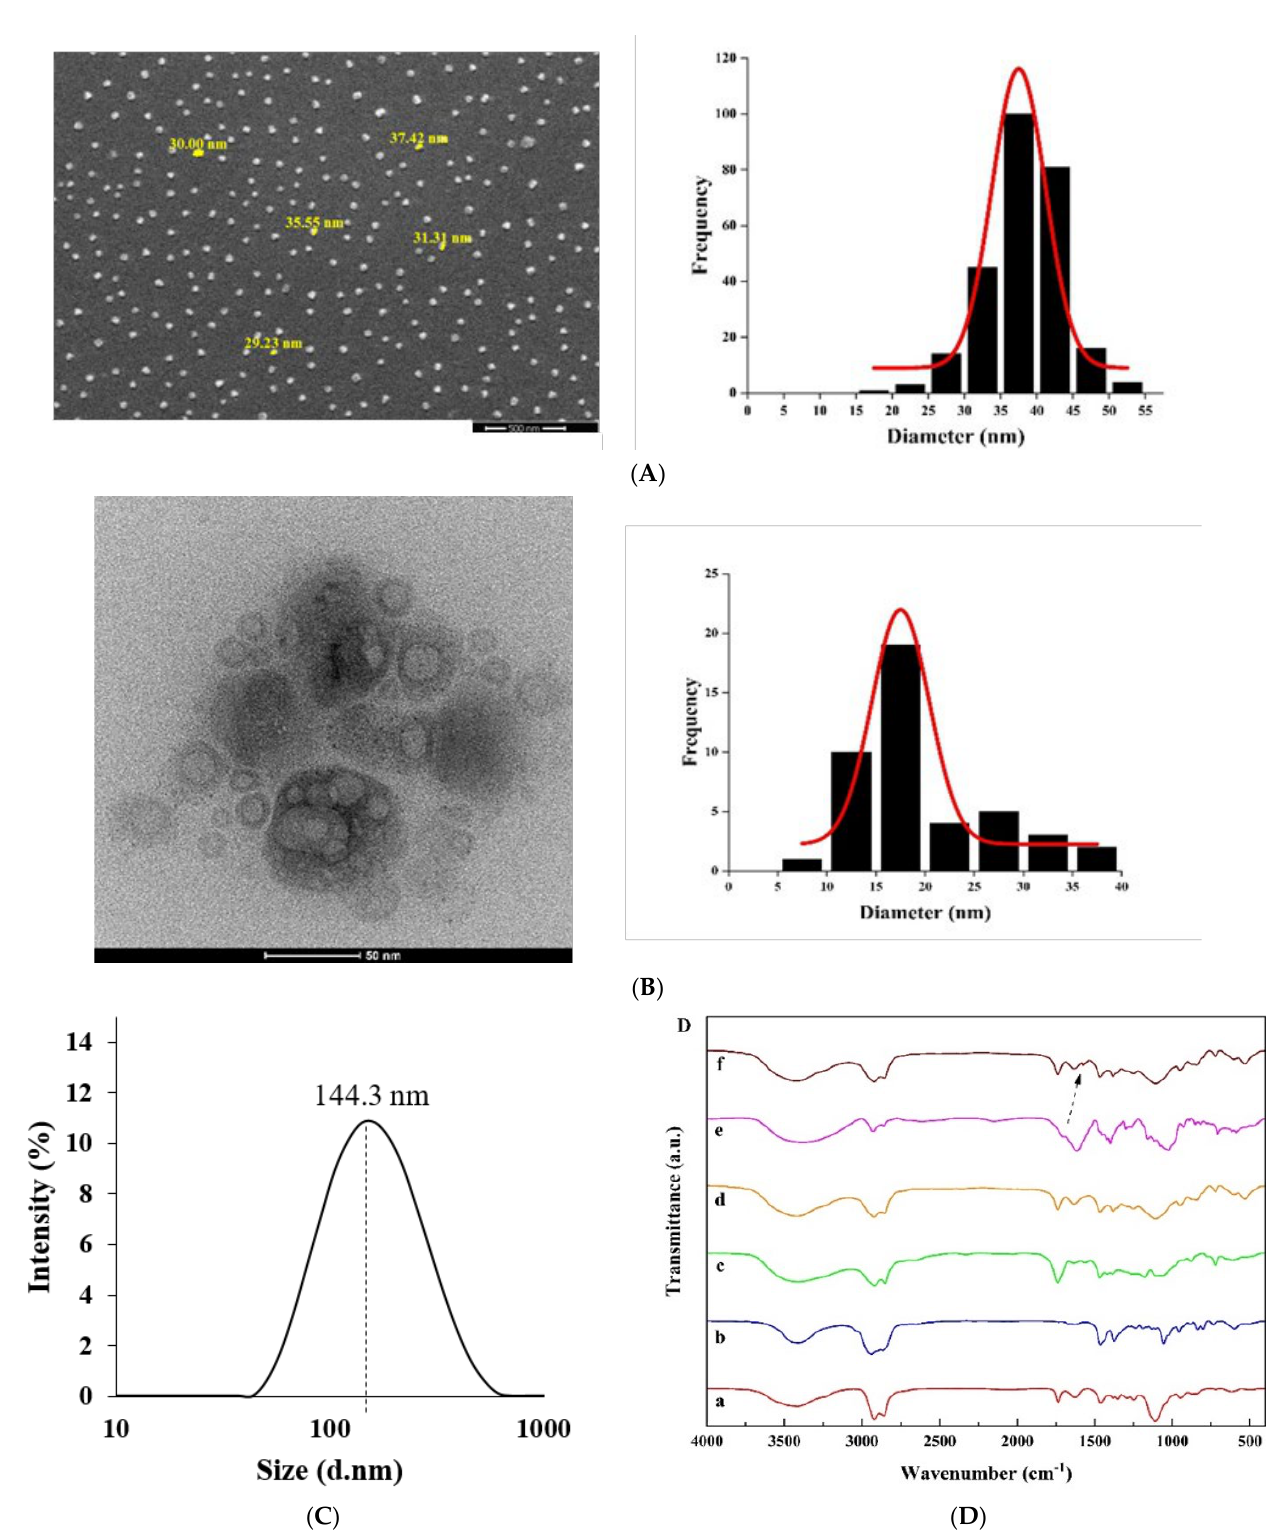
Figure 2. Morphological ascertainment of the optimized form. ( A ) Scanning electron microscopy (SEM), ( B ) transmission electron microscopy (TEM), ( C ) analysis of particle size distribution by dynamic light scattering (DLS), and ( D ) Fourier transform infrared (FTIR) spectra of (a) cholesterol, (b) Span 60, (c) Tween 60, (d) E. angustifolia , (e) Niosome, and (f) E. angustifolia -loaded niosome. Arrow: indicating the peak of E. angustifolia.